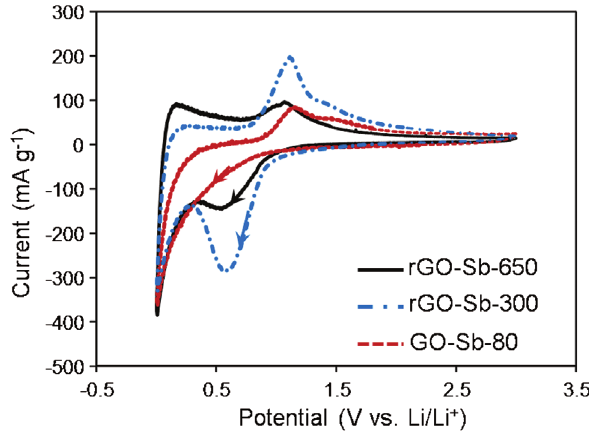
Figure 6: Cyclic voltammograms of the different electrodes during the second